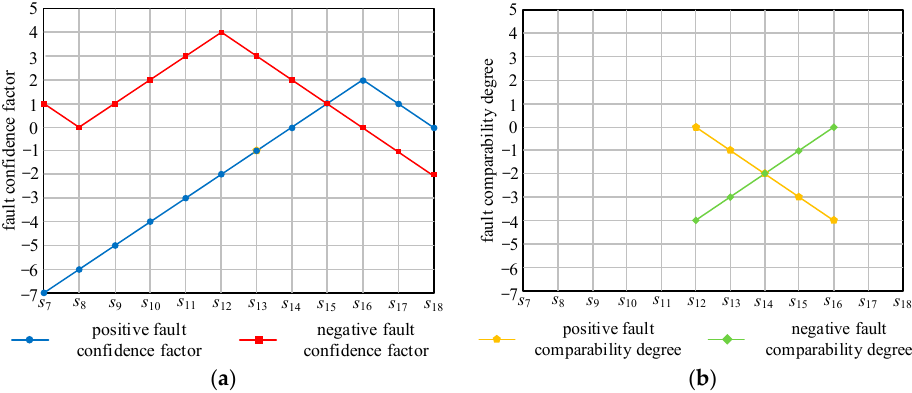
Figure 7. Correlation variables of dual power supply fault area. ( a ) Fault confidence factor; ( b ) fault comparability degree.